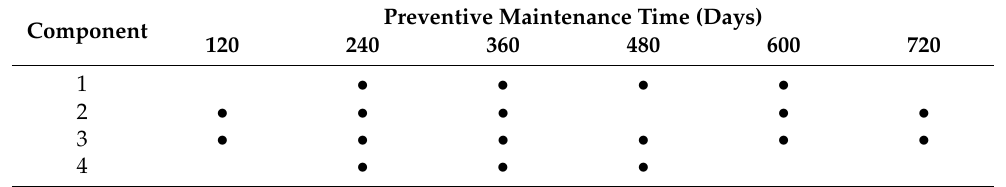
Table 11. System preventive maintenance plan under a combined maintenance strategy.